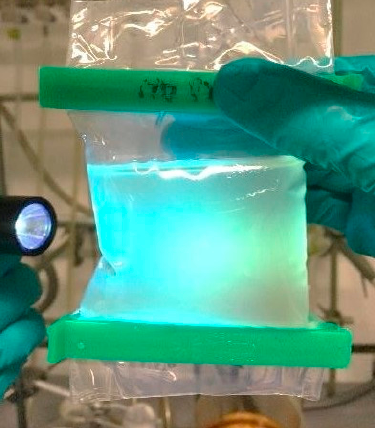
Figure 11. AMP-functionalized polymer dissolved in a dialysis membrane under the excitation at 366